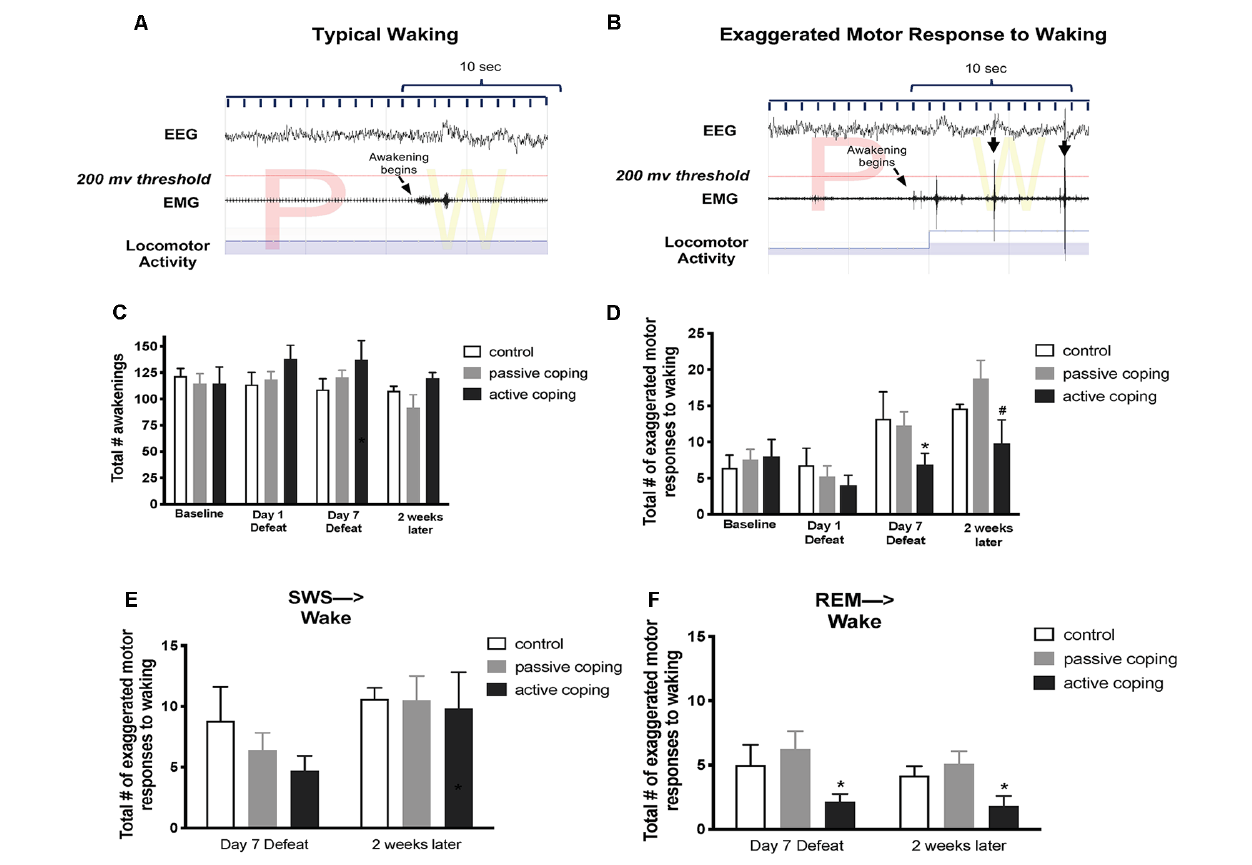
FIGURE 4 | Number of exaggerated motor responses during transitions to waking from SWS or REM sleep in the light period at baseline, Day 1 of defeat, Day 7 of defeat, and 2 weeks after the last defeat. (A) Representative typical awakening: a trace of EEG, EMG, and locomotor activity data during arousal from a REM sleep episode (initiated at arrow). Note that EMG spikes do not go above the 200 µ V threshold in red within 10 s of the sleep transition. (B) Representative exaggerated motor response at awakening: a trace of EEG, EMG, and locomotor activity data during arousal from a REM sleep episode (initiated at arrow). Note the recurrent EMG spikes greater than 200 µ V (denoted with black arrows) that occur within 10 s of the sleep transition with concurrent locomotor activity. (C) Total counts of awakenings during 6 h of the light period at baseline, defeat day 1, defeat day 7, and 2 weeks after the last defeat exposure. No significant differences in the total number of awakenings were detected between groups at any time point. (D) Total counts of exaggerated motor responses to waking during 6 h of the light period at baseline, defeat day 1, defeat day 7, and 2 weeks after the last defeat exposure. Actively coping rats ( n = 8) displayed less exaggerated motor responses to waking than both control ( n = 7) and passively coping rats ( n = 15) after day 7 of defeat, and this persisted 2 weeks later. (E,F) Exaggerated motor responses counted separately for arousals from SWS and REM sleep, respectively. Compared to control ( n = 7) and passively coping rats ( n = 15), actively coping rats ( n = 8) had significantly fewer exaggerated motor responses to waking from REM sleep specifically but not from SWS. * P < 0.05, # P < 0.1.